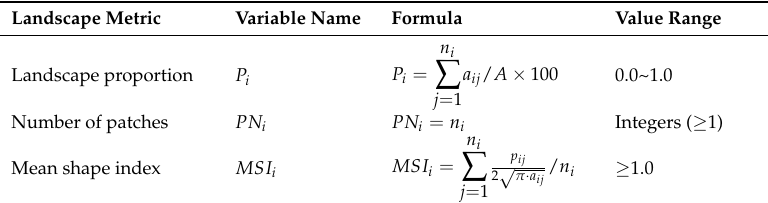
Table 1. The model parameters and their